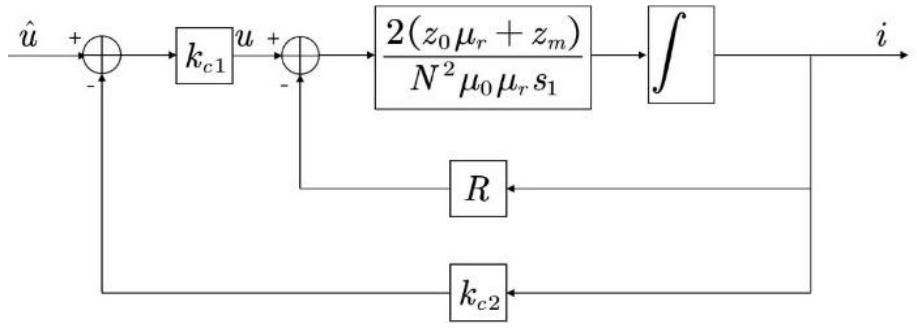
Figure 8. Current negative feedback dynamic structure.